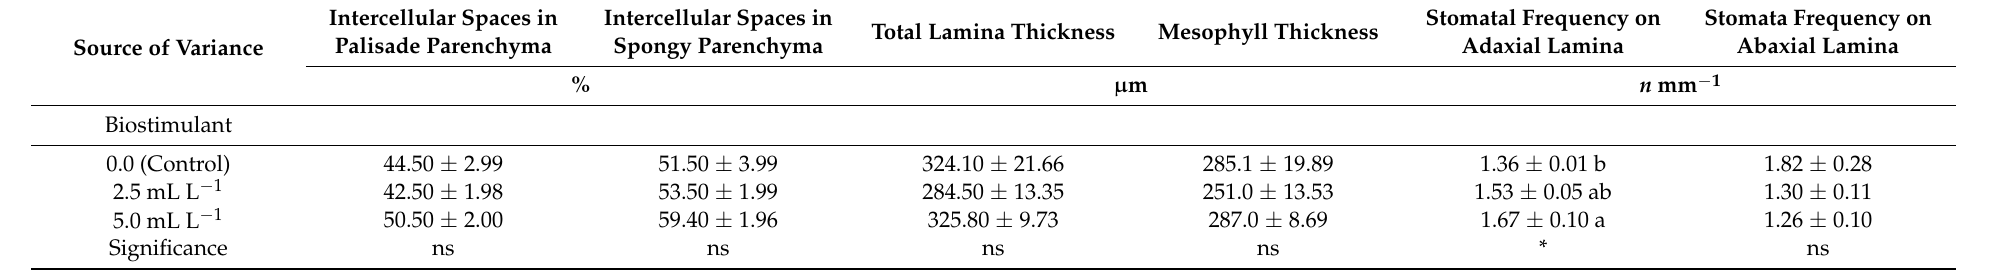
Table 3. The analysis of variance and mean comparisons for leaf anatomical traits of greenhouse lettuce cultivated under three biostimulant